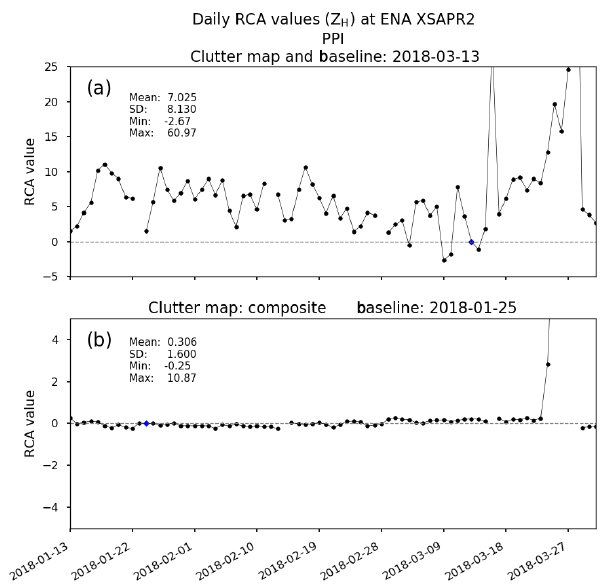
Figure 10. RCA time series for XSAPR2 at the ENA site calculated using 13 March 2018 for the clutter map and the baseline (a) and using the composite clutter map and 25 January 2018 for the base- line (b) . The high variability in the RCA value is reduced by using a composite map that accounts for daily temporal stability of the clutter.